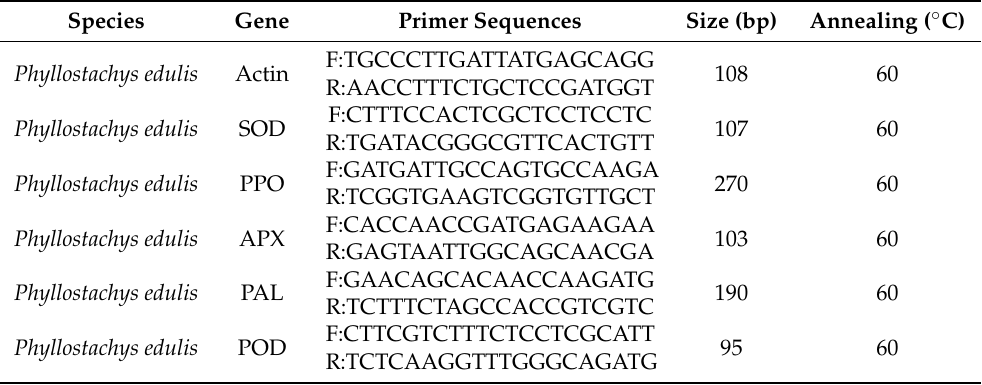
Table 1. The sequences of specific primers used for real-time PCR analysis and